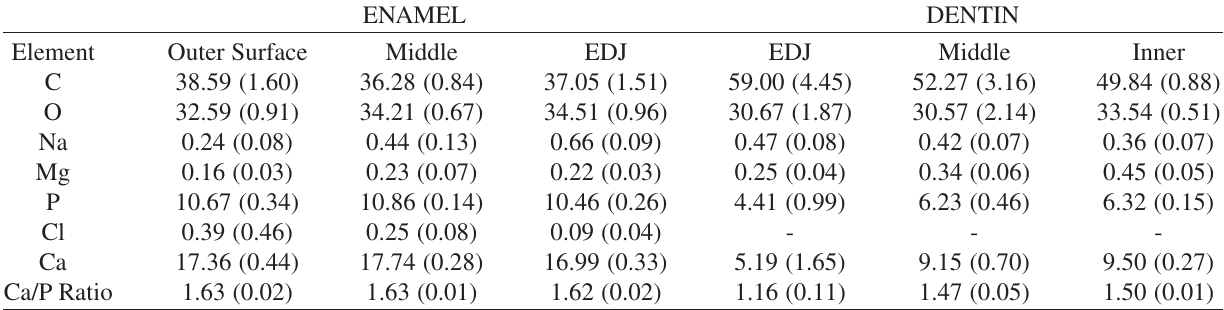
Table 4. EDS results from enamel and dentin. Data in at.% and they are the main values from 3 samples analyzed. EDS analysis was carried out from the outer enamel surface to EDJ in enamel, and from EDJ to the inner dentin layer in dentin. The data in the two EDJ columns were taken inside enamel and dentin respectively, but 20 µ m away from the EDJ in each case. The data for Na, Cl and Mg are graphically shown in Fig.